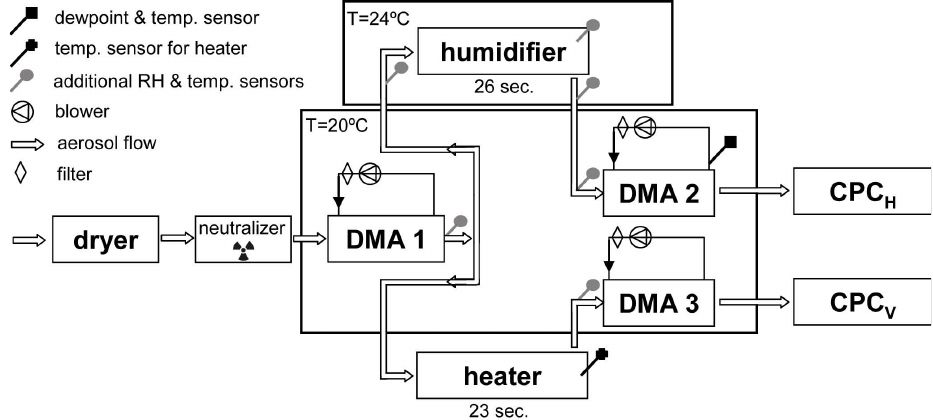
Fig. 2. Schematic of the combined volatility and hygroscopicity tandem differential mobility analyzer (V/H-TDMA) setup with the main instrument parts and sensors. The reference RH of the humidified branch is calculated from the dewpoint and temperature measured by a dew point mirror at the excess air outlet DMA2. The reference temperature for the V-branch is just before the outlet of the heater. The given residence times are measured between outlet of DMA1 and DMA2 or DMA3,